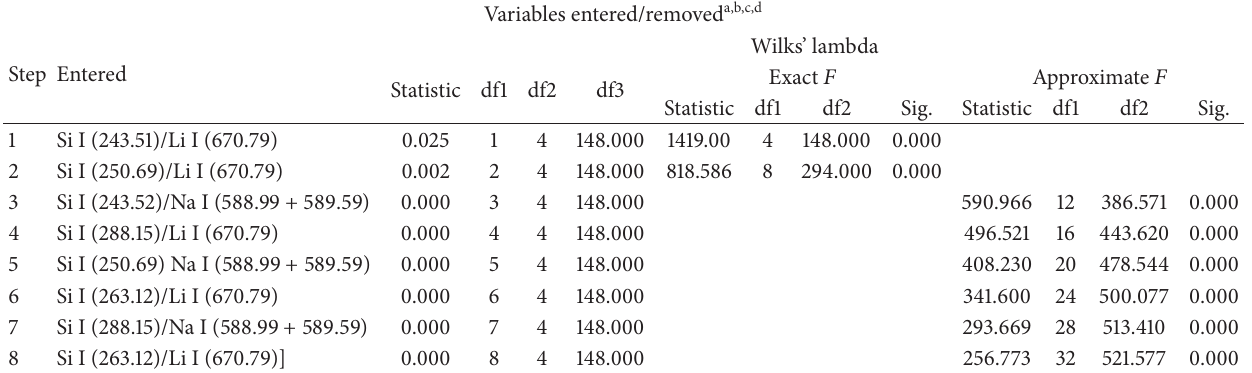
Table 1: Variables that are used a,b in the analysis at each step.